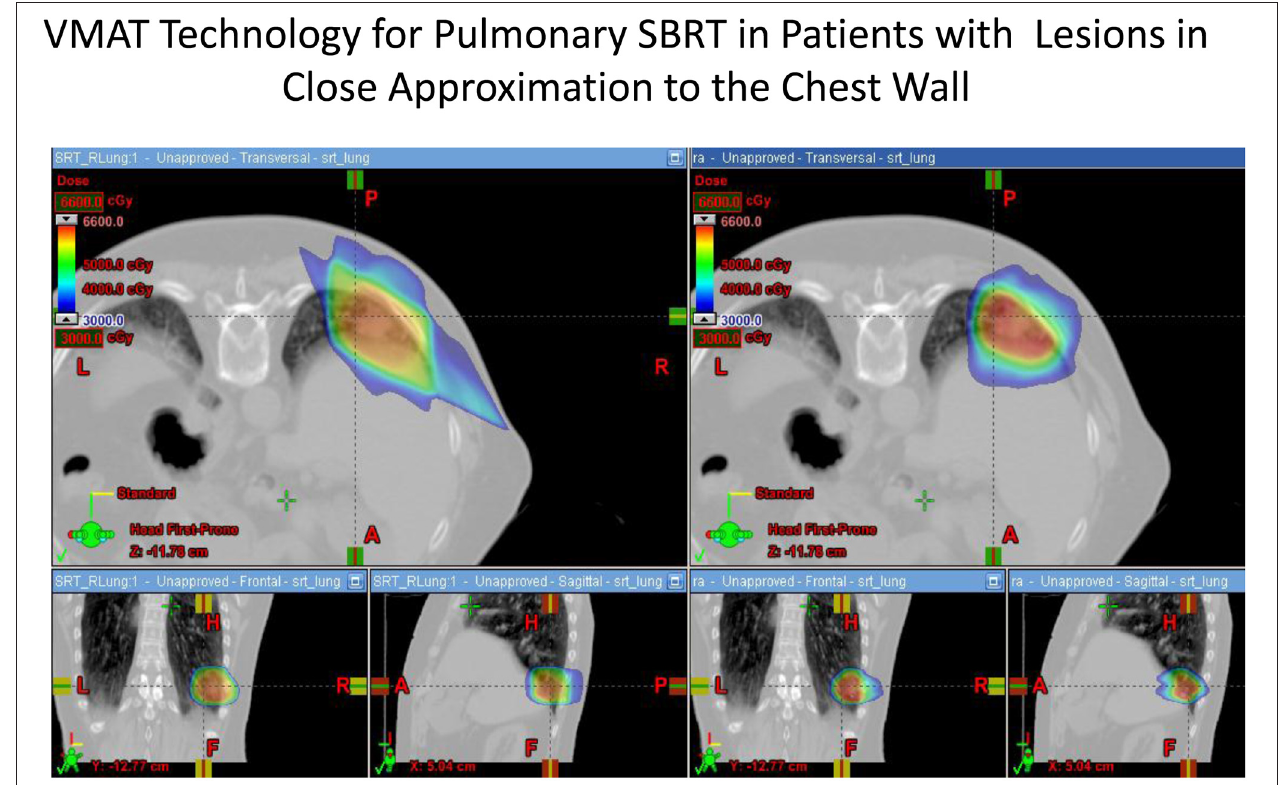
FIGURE 2 | Demonstrates improvement in dosimetry to the chest wall and ribs in a patient in the prone position with a lesion in the posterior segment of the right lower lobe. The static field plan is on the left and the VMAT plan is on the right.